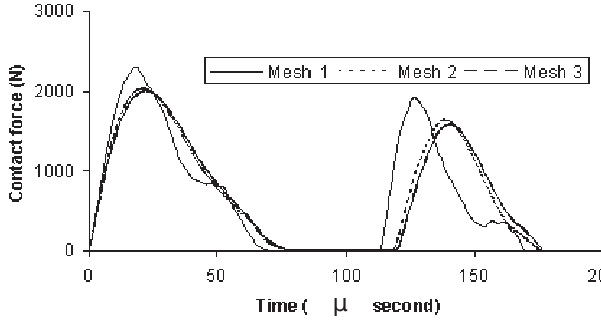
Fig. 7. Variation of adaptive contact force (point contact) on composite plate with respect to time.